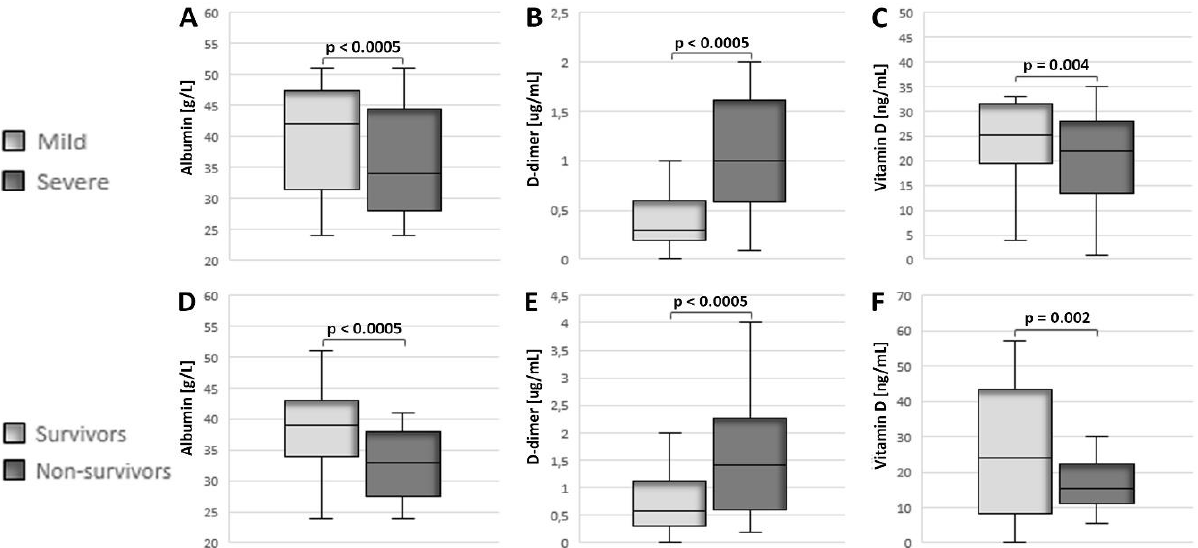
Figure 2. Serum values of albumin, D-dimer, and vitamin D in patients with COVID-19 in relation to the severity of the clinical picture and the outcome of the disease. The patients were divided into groups with mild (n = 134) and severe (n = 154) clinical pictures as well as groups with favorable (n = 265) and fatal (n = 23) disease outcomes. The serum values of the examined biochemical parameters were obtained from blood samples immediately after admission to the hospital for treatment. ( A ) Differences in serum albumin (Mdn = 42.0 g/L (39.0, 44.0), n = 134 vs. Mdn = 34.0 g/L (32.0, 38.0), n = 154; p < 0.0005); ( B ) D-dimer (Mdn = 0.3 ug/mL (0.2, 0.6), n = 134 vs. Mdn = 1 ug/mL (0.6, 1.6), n =